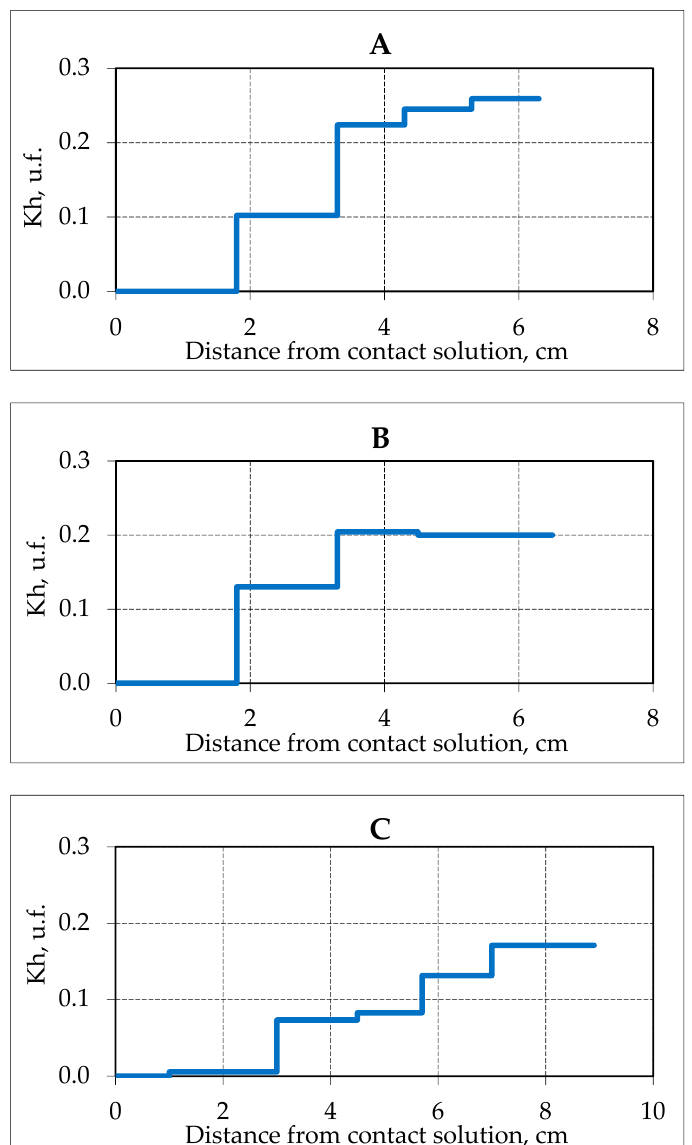
Figure 9. Changes in the hydration coefficient (K h ) in samples of frozen hydrate saturated sand (sand 2, W = 16%) after 3 h of contact with NaCl solution of various concentrations at a temperature of − 3 °C. ( A – C ) solution concentration, respectively, 0.1, 0.2 and 0.4 N. Data on the change in hydrate content of frozen hydrate-saturated sediments when interacting with a saline solution were used to estimate the kinetics of methane emission from frozen samples during decomposition of pore gas hydrates depending on temperature (Figure 10).